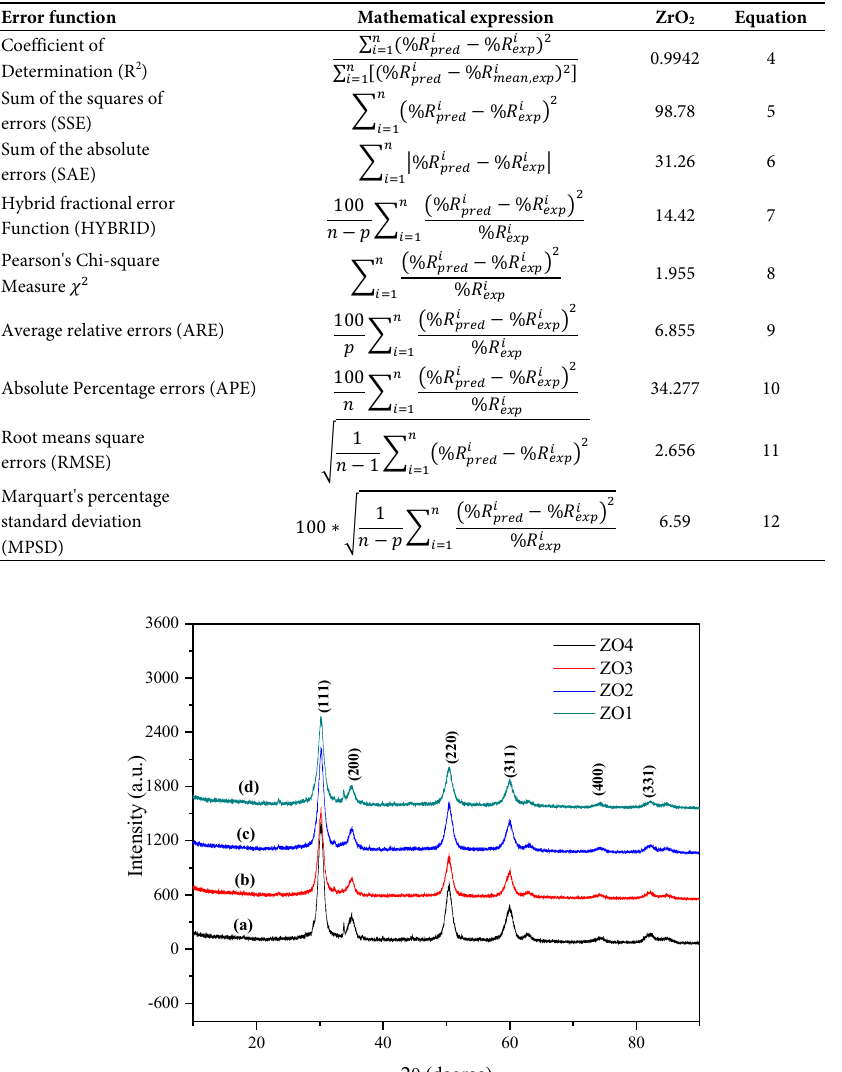
Table 2: List of non-linear error functions as the statistical goodness of fit measures Error function